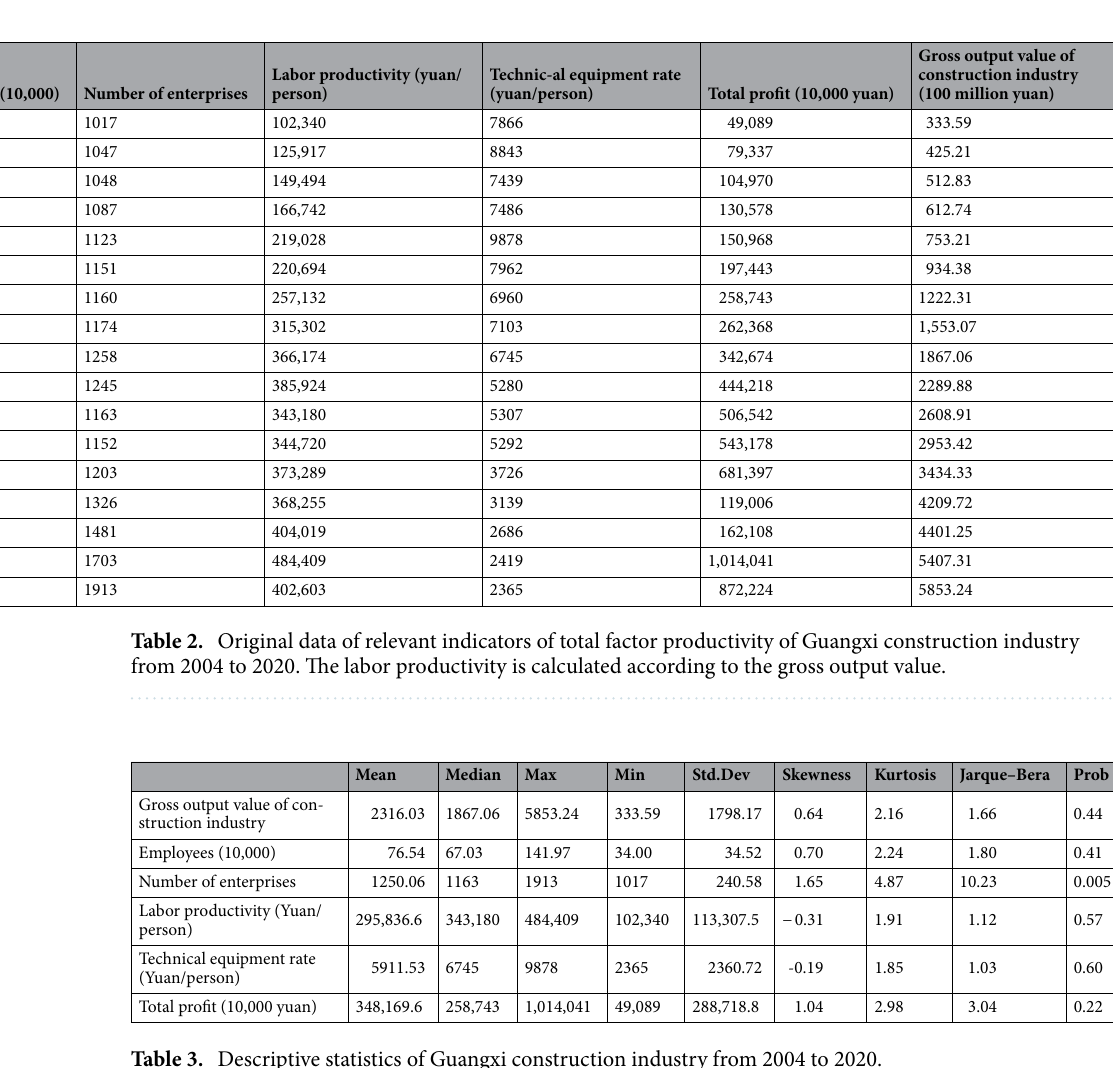
Table 3. Descriptive statistics of Guangxi construction industry from 2004 to